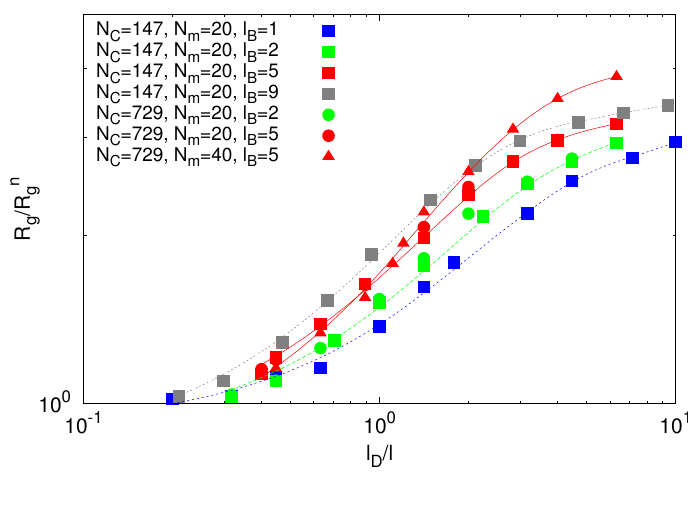
Figure 6. The dependence of the radius of gyration, R l , for various Bjerrum lengths, l D the radius of gyration of a microgel under good solvent conditions.